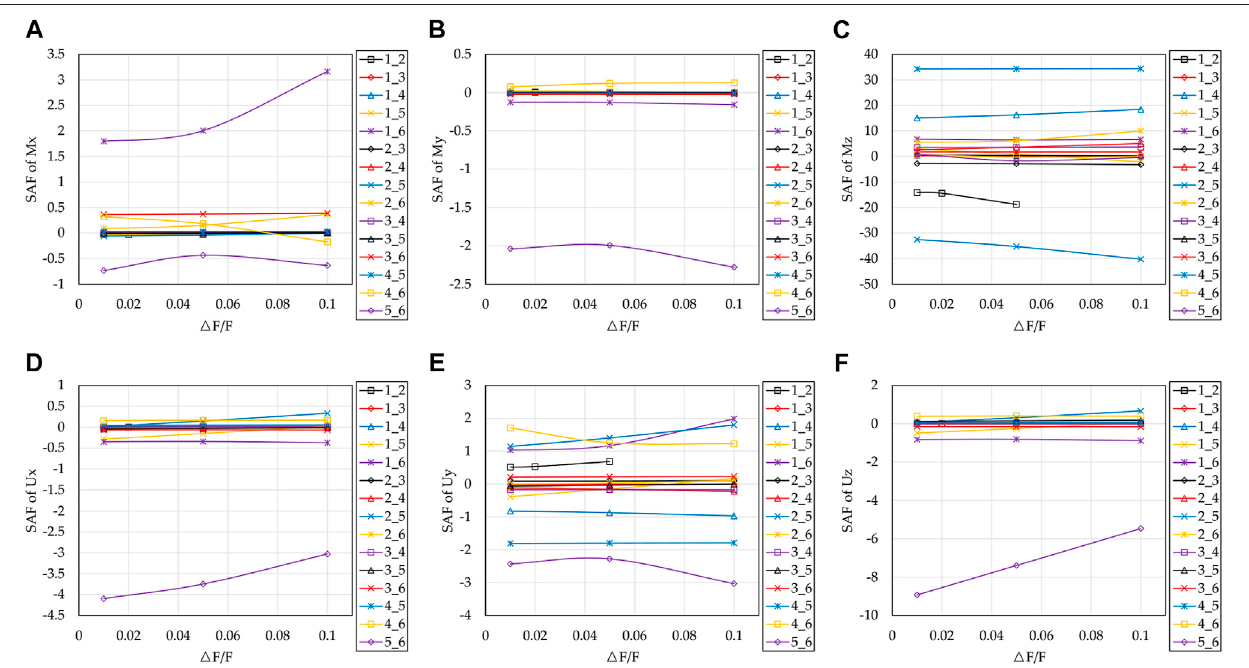
FIGURE 10 | In fl uence of non-main diagonal stiffness coef fi cient on medium and high sensitivity.